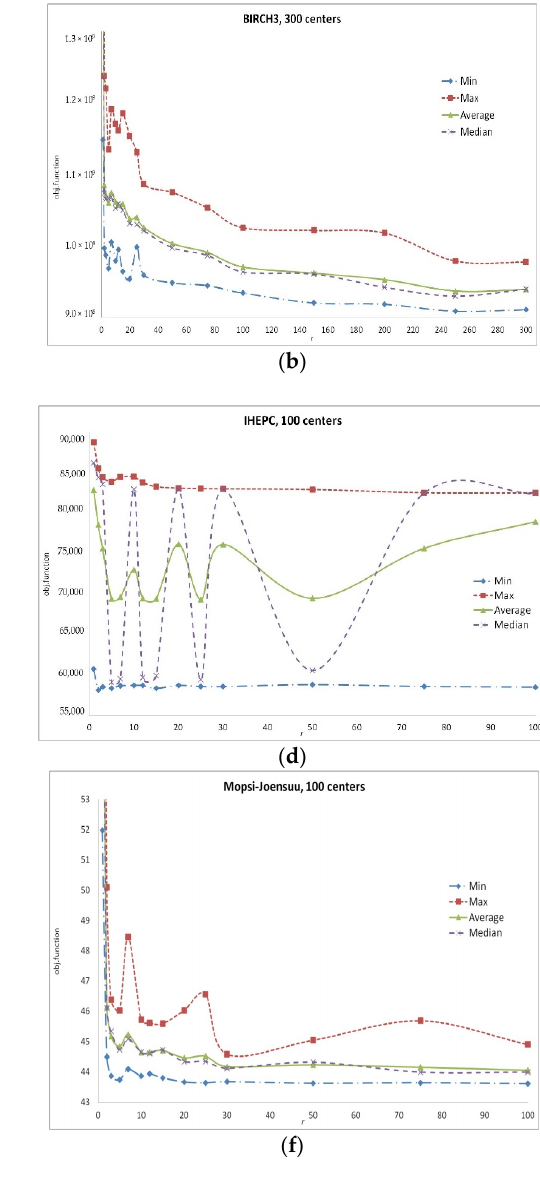
Figure 2. Comparative results of the search in AGGL r neighborhoods. Dependence of the result (1) on r : ( a , b ) BIRCH3 dataset, search for 100 and 300 centers, respectively, 100,000 data vectors, time limitation 10 s; ( c , d ) IHEPC dataset, search for 30 and 100 centers, respectively, 2,075,259 data vectors, time limitation 300 s; ( e ) Mopsi-Finland dataset, search for 300 centers, 13,467 data vectors, time limitation 5 s; ( f ) Mopsi-Joensuu dataset, search for 100 centers, 6014 data vectors, time limitation 5 s.